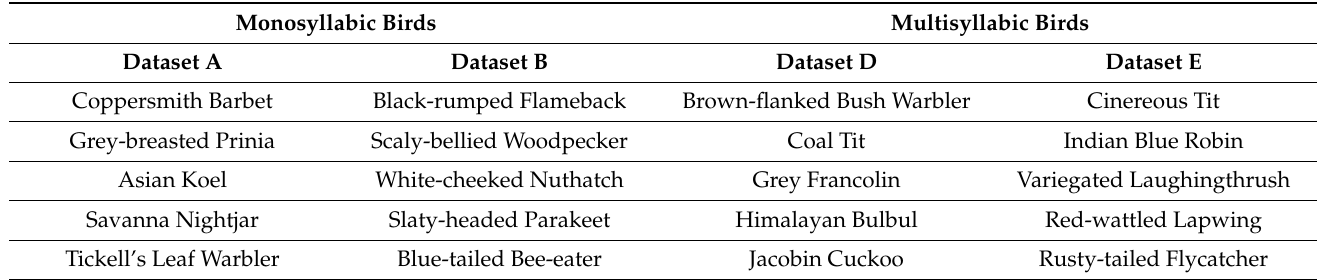
Table 1. The datasets used in the